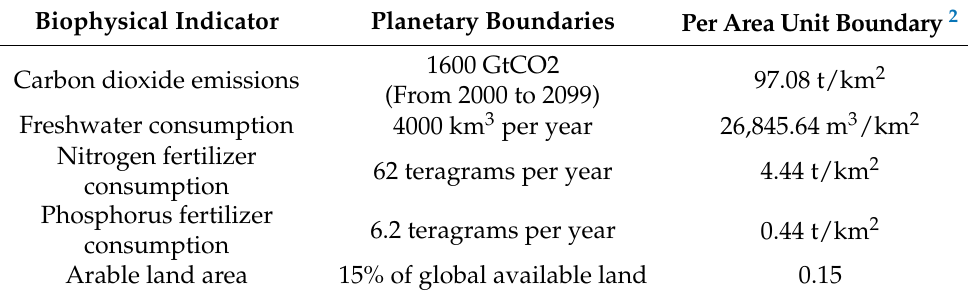
Table 1. The setting of per capita Planetary